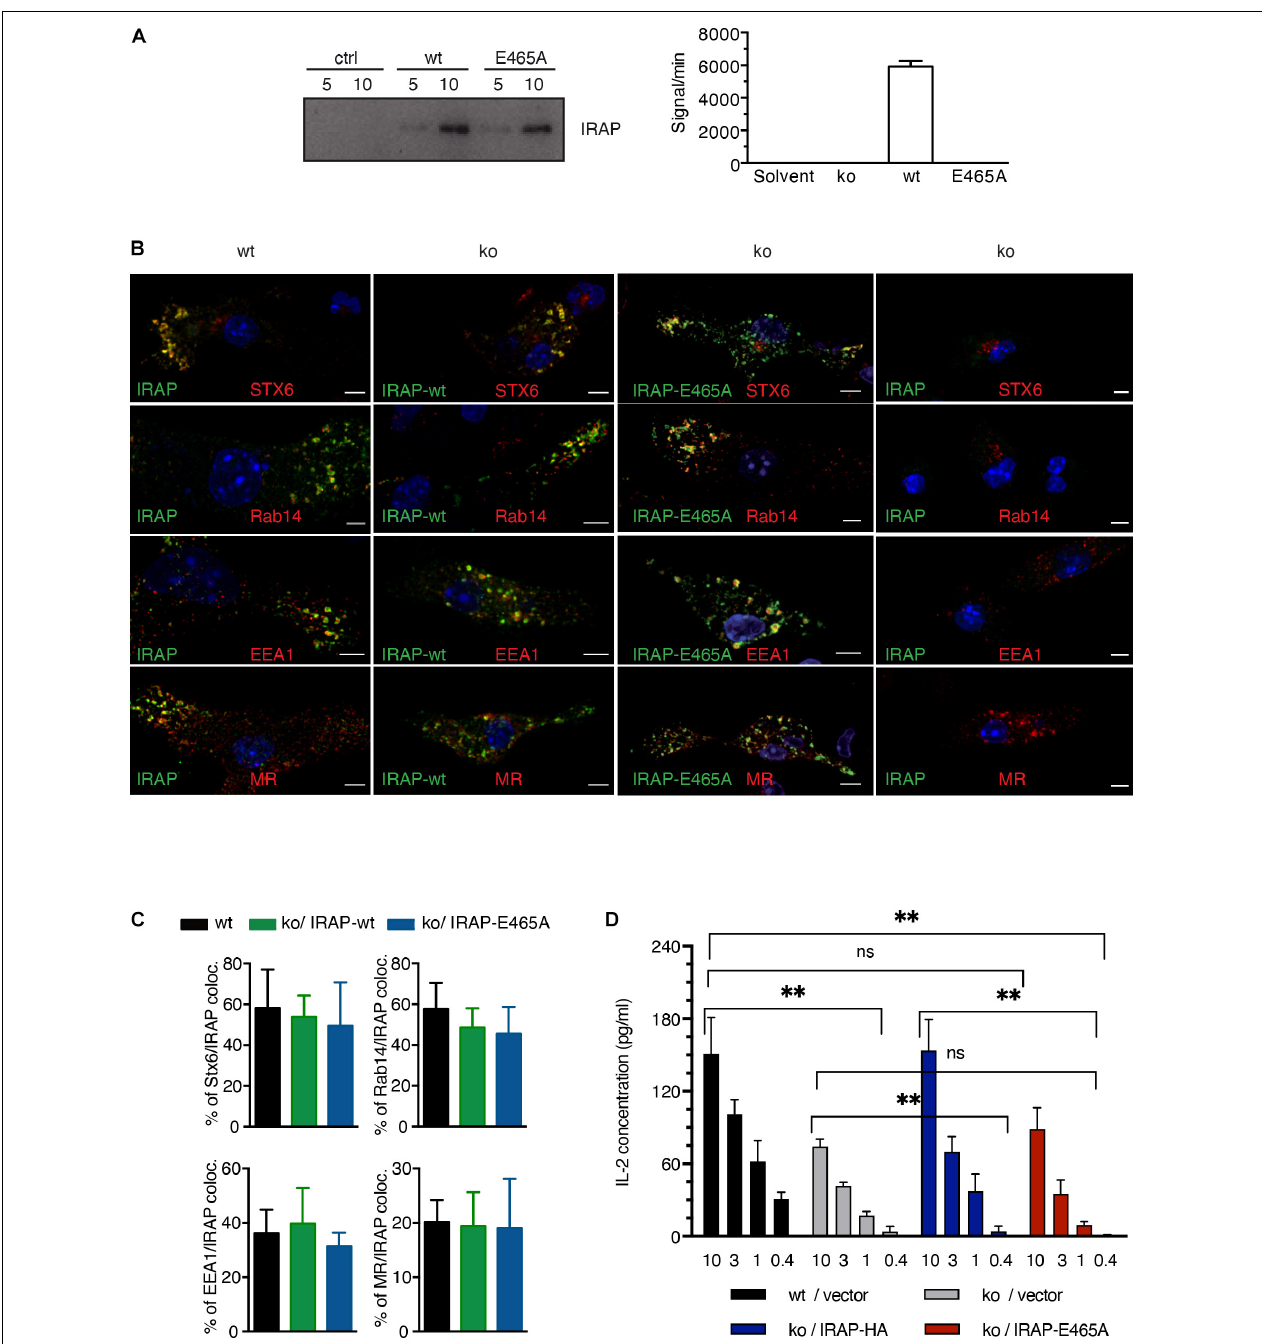
FIGURE 3 | Insulin-regulated aminopeptidase (IRAP) peptidase activity is required for efficient cross-presentation. (A) IRAP − / − mouse epithelial fibroblasts (MEFs) were transfected with full-length wild-type (wt) or mutant IRAP or mock-transfected (ctrl), followed by immunoprecipitation of IRAP 2 days later. The precipitates were analyzed for IRAP content by immunoblot and for peptidase activity toward the fluorogenic Arg-AMC substrate using mock-transfected cells as control. (B) IRAP − / − bone marrow-derived DCs (BM-DCs) were nucleofected with the plasmid pMAX-IRAP-E465A and analyzed 36 h later by confocal microscopy. Wt and untransfected IRAP − / − BM-DCs are shown as controls. (C) The colocalization of storage endosome markers in IRAP wt and IRAP − / − BM-DCs transfected with wt or protease-dead IRAP was analyzed for five representative cells. The graph shows mean co-localization ± SEM. (D) IRAP + / + or IRAP − / − BM-DCs were nucleofected with empty pIRES2-GFP or the active site IRAP mutant E465A cloned in pIRES2-GFP. Live transfectants were sorted as GFP + 7AAD − CD11c + CD11b + cells and put in contact with graded amounts (mg/ml) of pre-formed complexes formed between MR antibodies and OVA fusion protein and with OT-I T cells. T cell stimulation was assessed by interleukin (IL)-2 ELISA. Histograms show the mean concentration of IL-2 ± SEM after subtraction of values obtained with control Glutamic acid decarboxylase (GAD) fusion protein from four independent experiments. ∗∗ p < 0.01; ns, not significant.